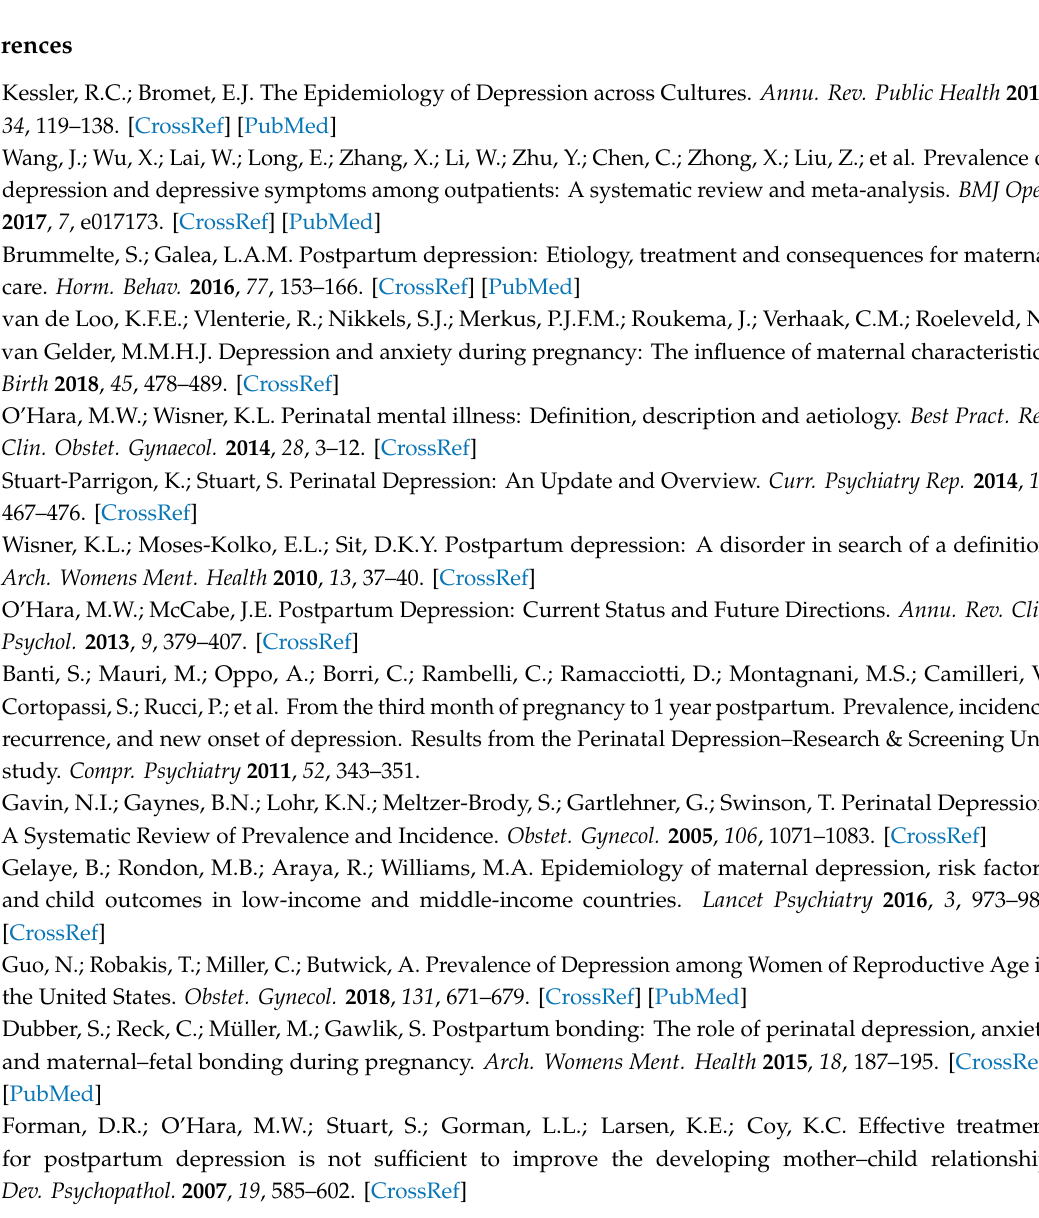
Table S1: Quality assessment scores; Demographic characteristic of systematic review